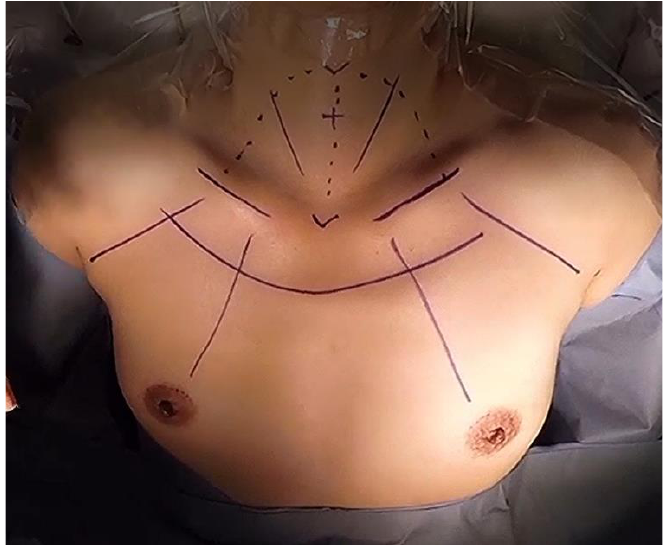
Figure 2. port insertion sites of endoscopic bilateral axillo-breast approach (BABA). Figure 2. Port insertion sites of endoscopic bilateral axillo-breast approach